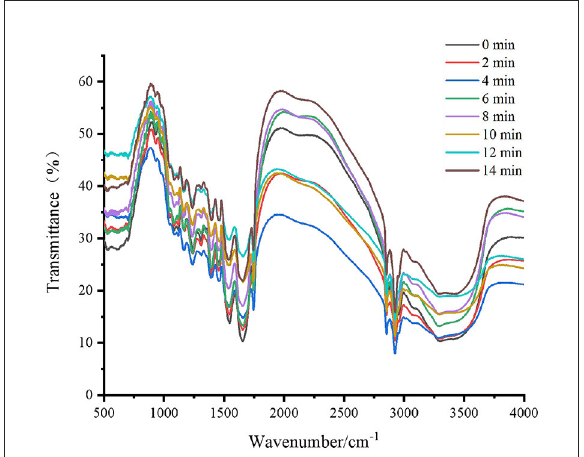
FIGURE4 Fourier transform infrared spectroscopy (500–4000 cm − 1 ) from roasted Tan mutton at different roasting time.